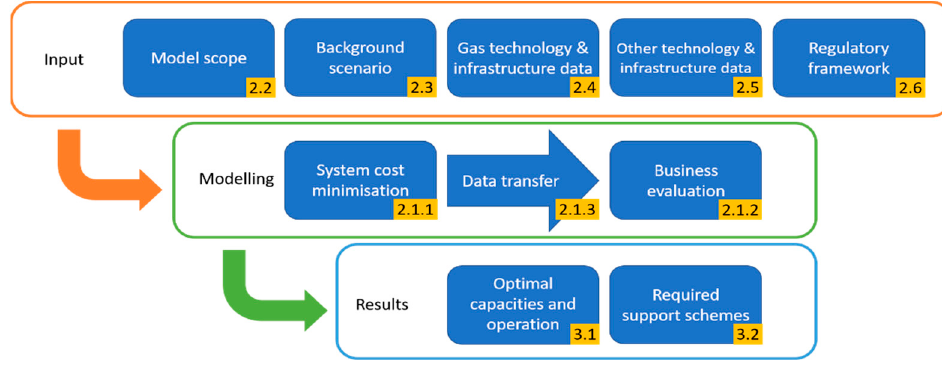
Figure 1. Overview of the modelling procedure and indication of respective sections in the paper.